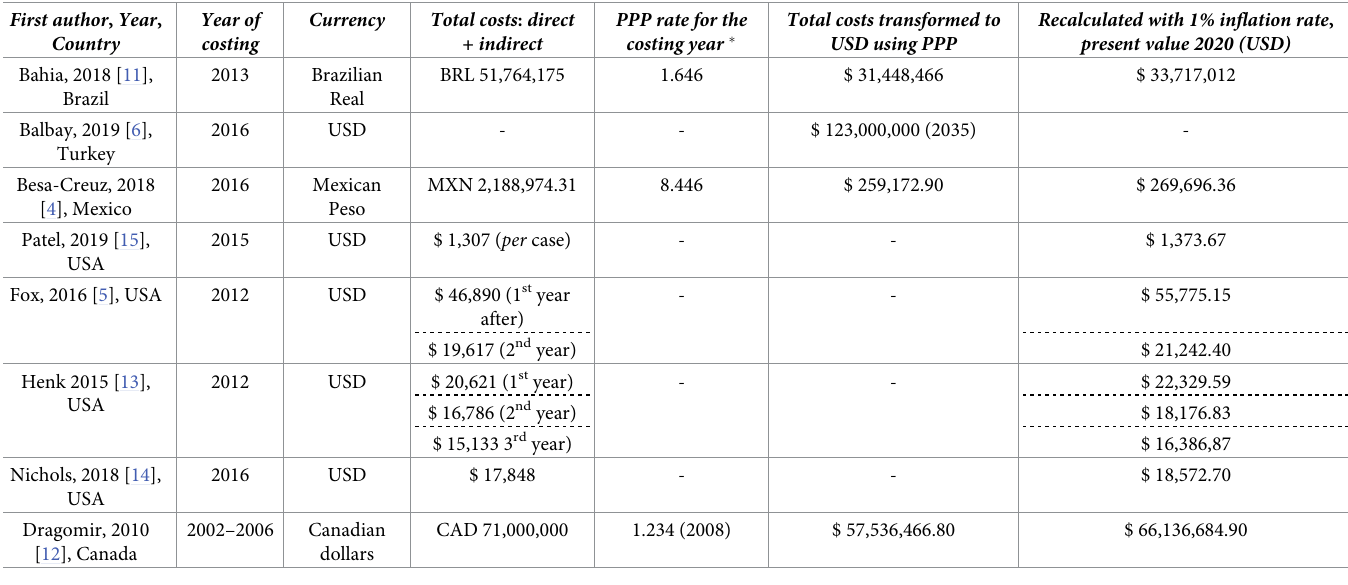
Table 2. Presentation of costs for each study after transforming costs to US dollars using Purchasing Power Parities (PPP), by inflating 1%